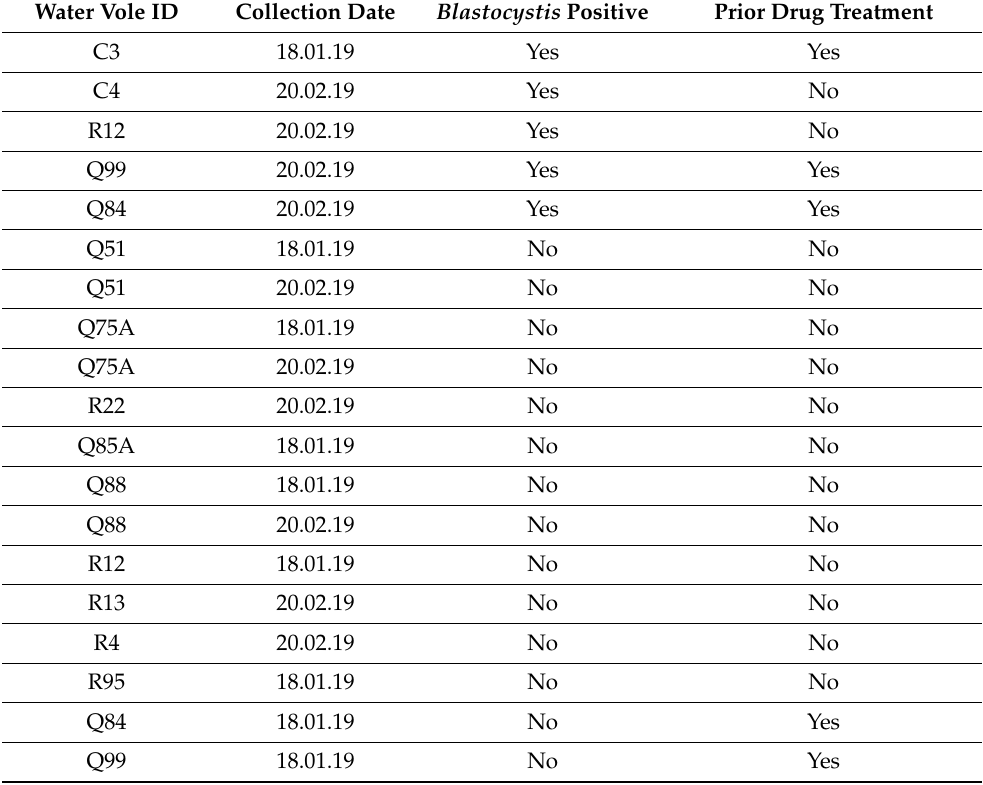
Table A2. Summary of the voles that will be included in subsequent analysis for Blastocystis -related investigation. Previous drug treatment (ending 10+ days prior to collection) was also